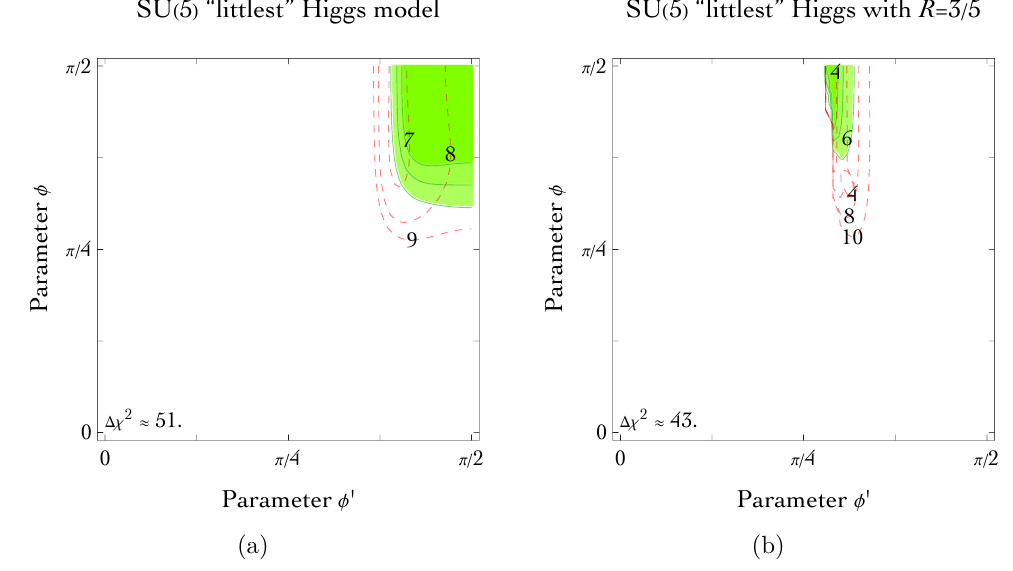
Figure 6. Best-fit regions on the parameters of SU(5) little-Higgs models. The red dashed contours indicate the values of the scale f in TeV. As described in the text, in each model the angles φ parameterize the gauge couplings of the extra gauge groups, which become strongly coupled at φ, φ 0 → 0 , π/ 2